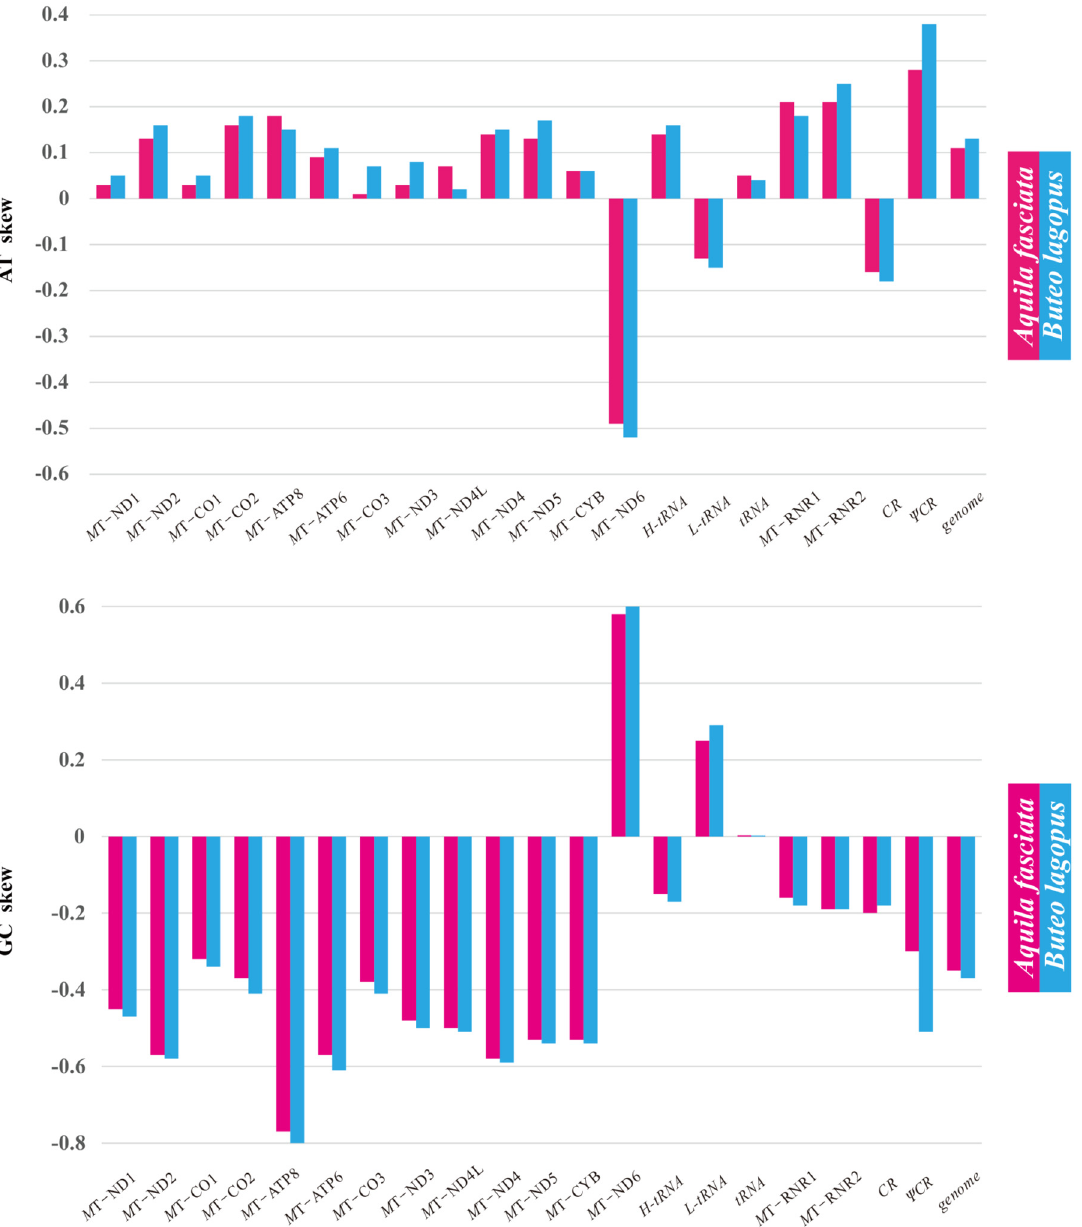
Fig 3. Base composition of A . fasciata and B . lagopus mitochondrial genomes. AT skew and GC skew are calculated for each protein-coding gene and other gene regions.